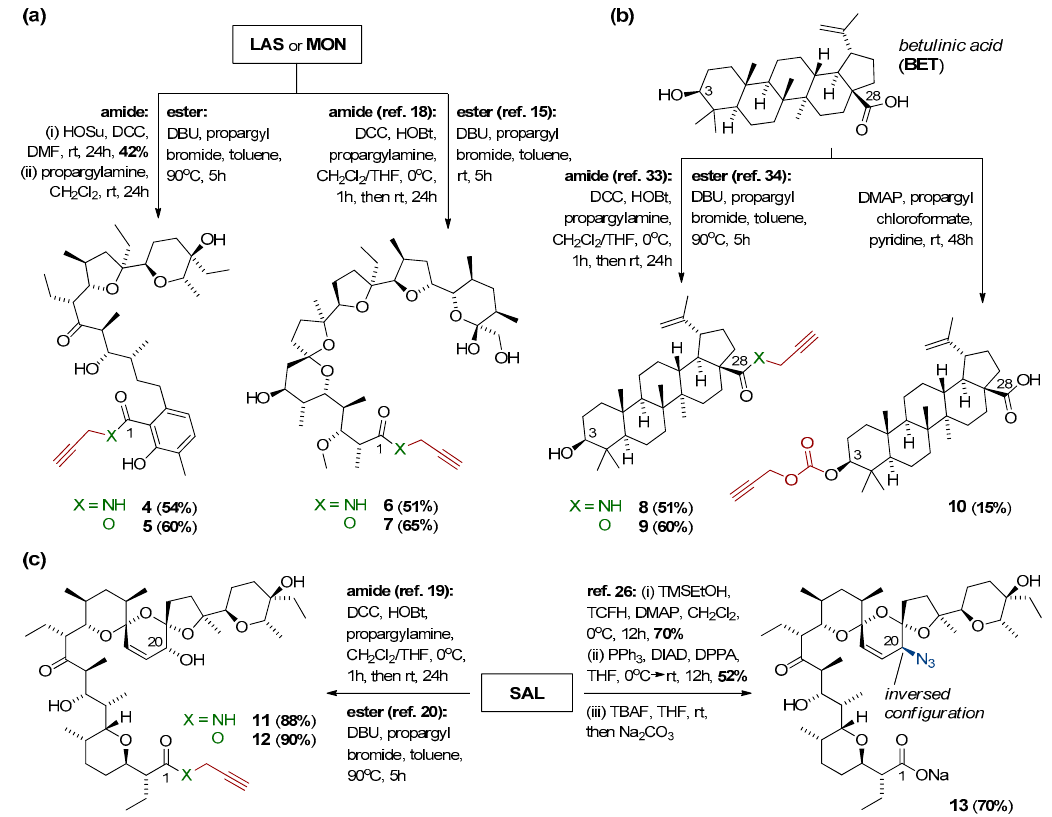
Figure 1. ( a ) Structures of polyether ionophores studied in this work, and ( b ) the literature-known salinomycin homodimers conjugated via the C20 hydroxyl [29,30].